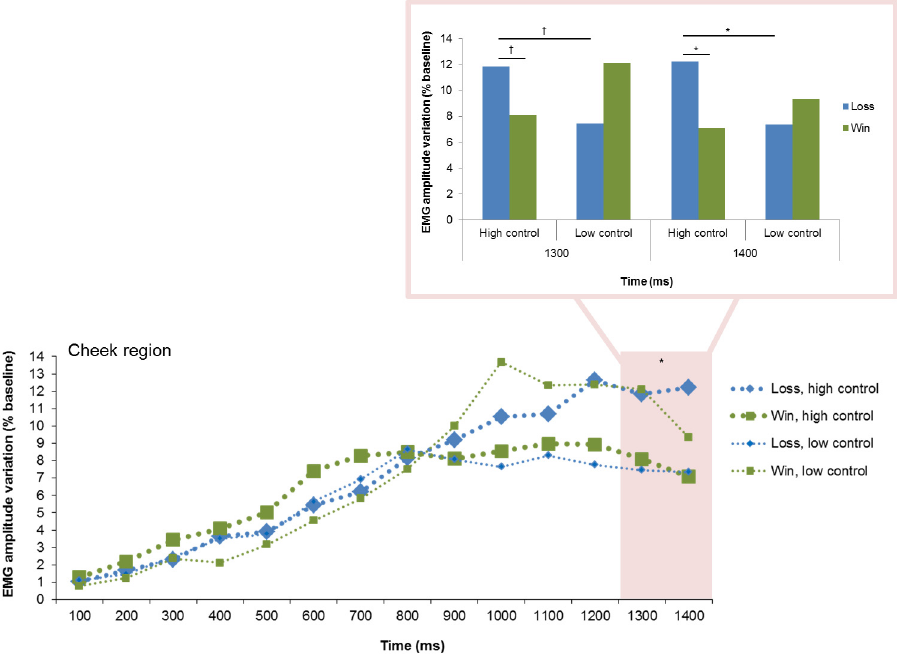
Fig 10. Electromyographic (EMG) amplitude variations over the cheek region, illustrating the interaction of goal conduciveness and control across time. † p < .10, * p < .05.